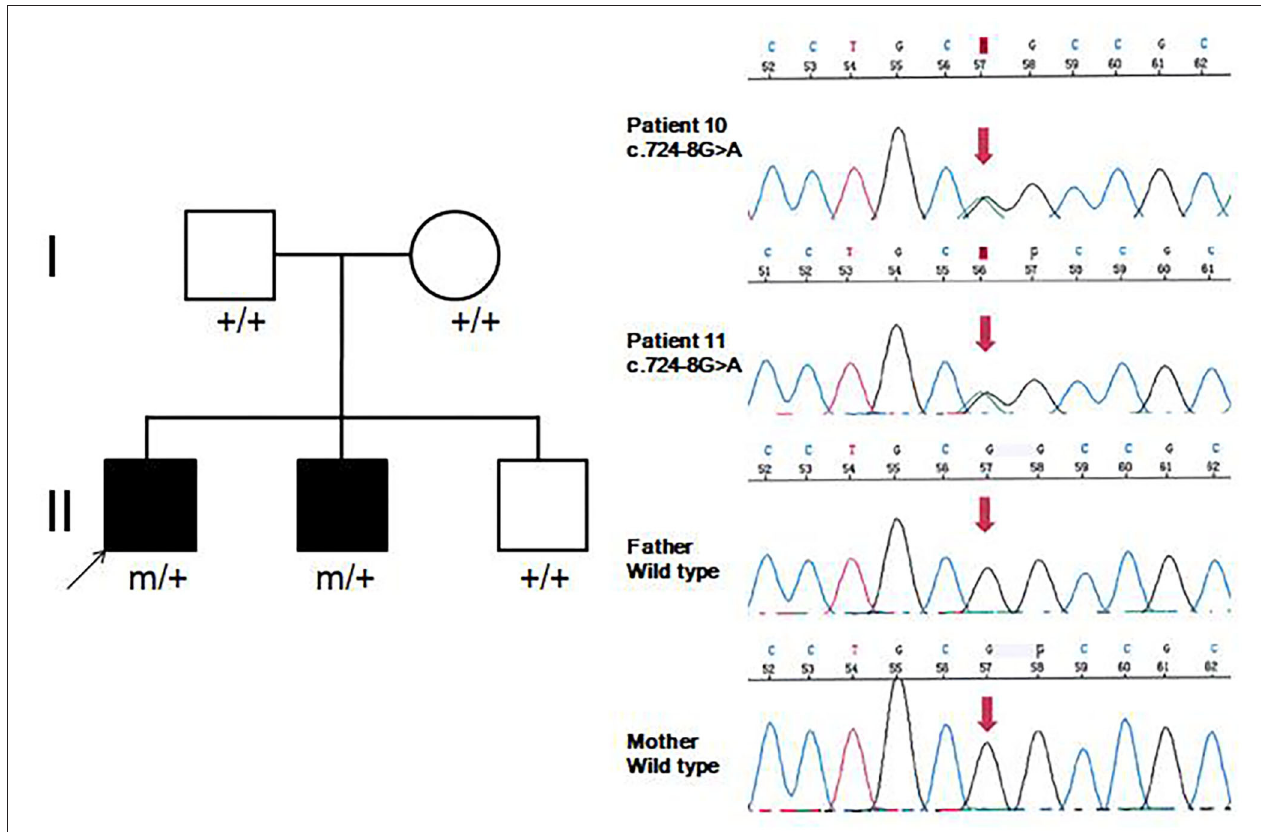
FIGURE 1 | Family pedigrees and sequence chromatograms of the two brothers. The proband and his younger brother (Patients 10 and 11) were both identified with the c.724-8G > A variant, which was further verified as de novo in peripheral blood DNA.